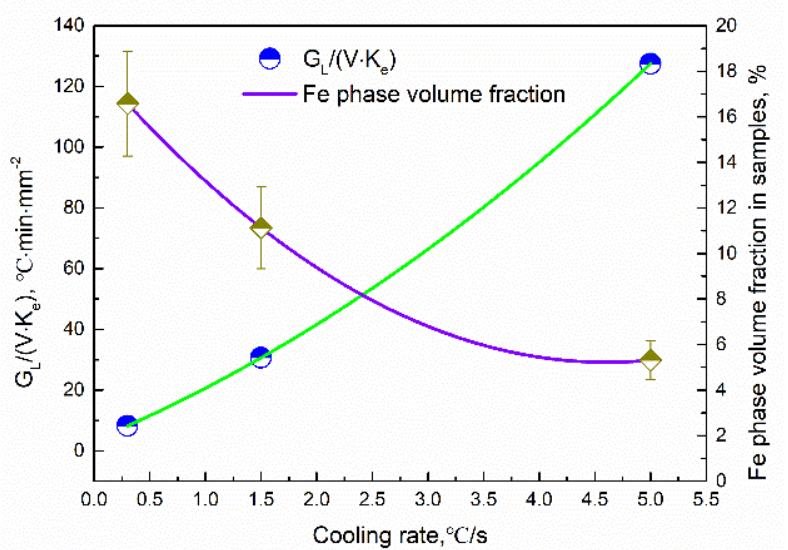
Figure 10. Relation between cooling rates and Fe phase volume fraction: the constitutional undercooling.